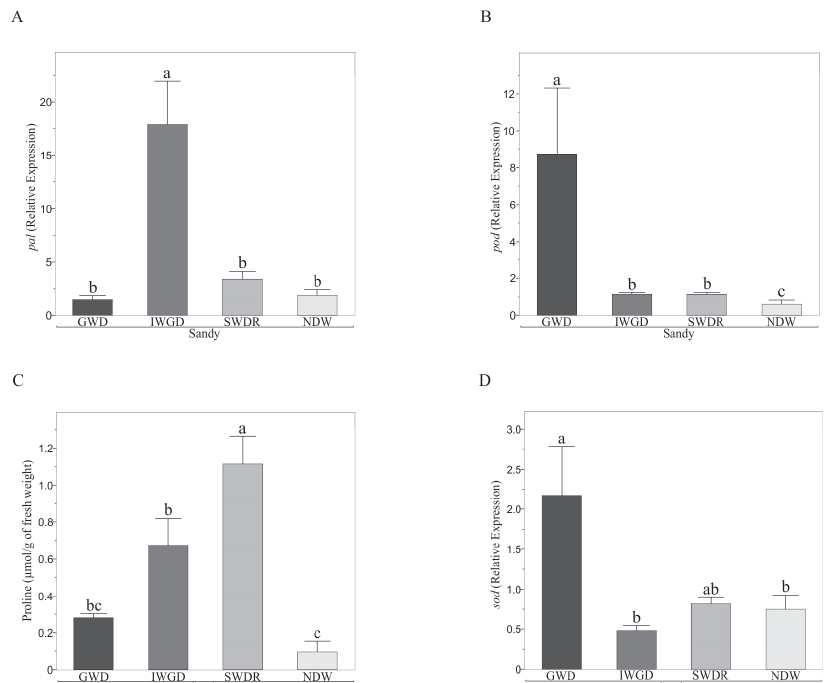
Figure 10. Biochemical variables in chili pepper plants grown in the sandy soil. Results of the comparison of means ± S.E. by using Tukey of the biochemical variables. ( A ) Phenylalanine ammonia-lyase ( PAL ); ( B ) Peroxidase ( POD ); ( C ) Proline; ( D ) Superoxide dismutase ( SOD ). In all cases p = 0.05. Gradual water deficit (GWD), initial waterlogging with gradual water deficit (IWGD), sudden water deficit with gradual recovery (SWDR), no deficit of water (NDW).